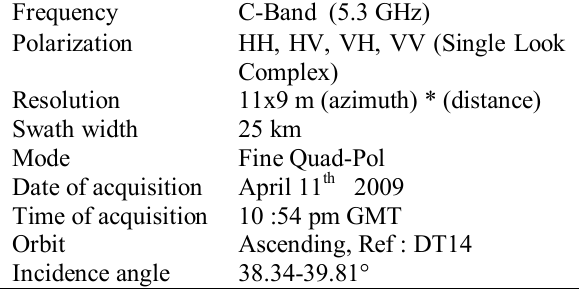
Table 1: Polarimetric data characteristics Frequency C-Band (5.3 GHz)